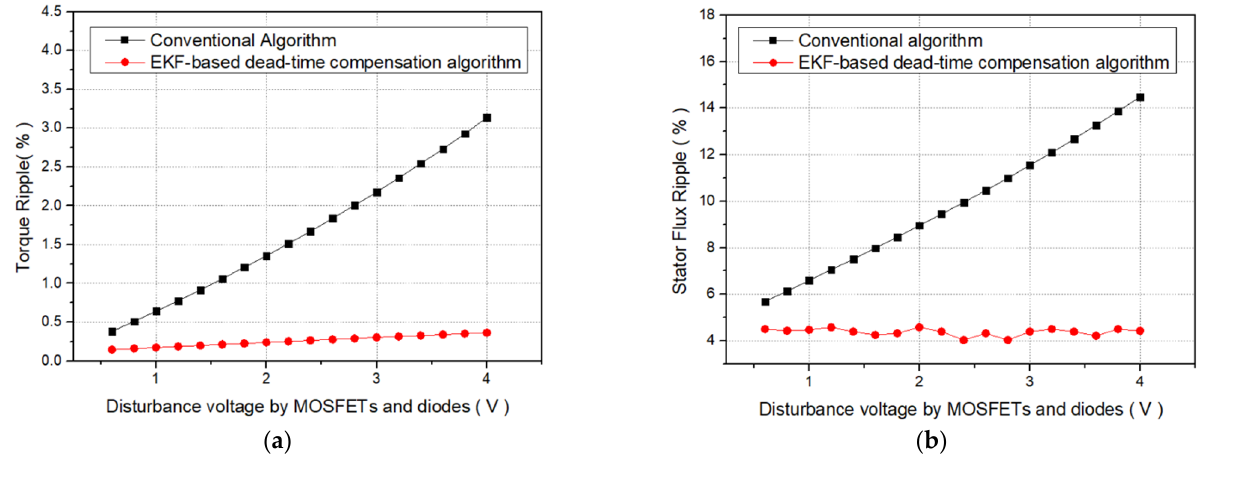
Figure 19. ( a ) Comparison of torque ripple for disturbance voltage generated by MOSFETs and diodes when applying the conventional algorithm and the proposed EKF-based control algorithm ( b ) Comparison of stator flux ripple for disturbance voltage generated by MOSFETs and diodes when applying the conventional algorithm and the proposed EKF-based control algorithm.